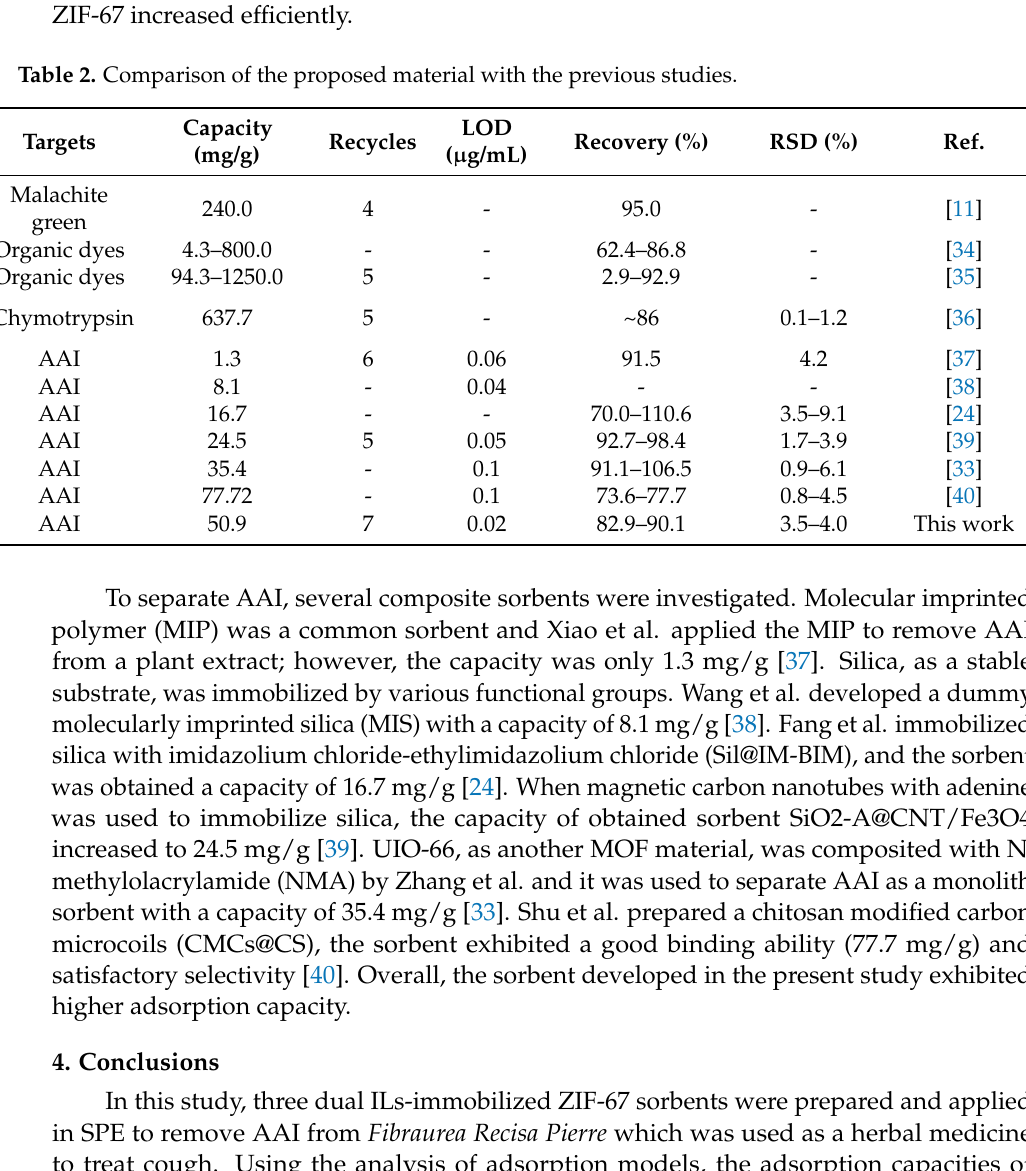
Figure S2: FT-IR of ZIF-67, ZIF-67@EIM-Cl, ZIF-67@EIM-IM, ZIF-67@EIM-MIM and ZIF-67@EIM- EIM, Figure S3: TGA analysis of ZIF-67, ZIF-67@EIM-Cl and ZIF-67@EIM-MIM, Figure S4: